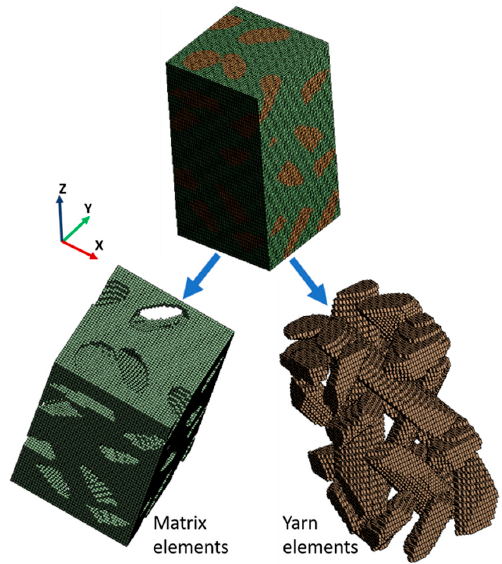
Figure 7. Meso-scale meshed model.